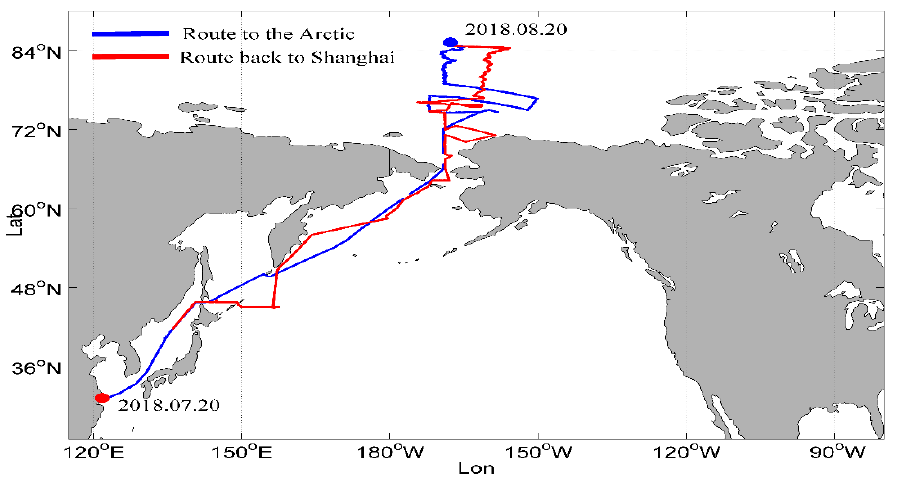
Figure 4. The navigation trajectory of the Chinese ninth Arctic science expedition.